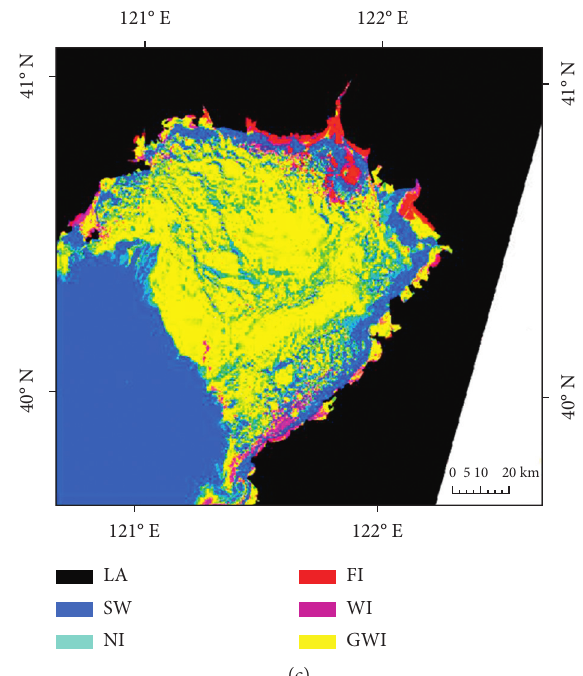
Figure 9: Comparison of sea ice classification results by different methods for the images acquired from 11 February 2019. (a) Classification result of maximum likelihood method; (b) classification result of support vector machine method; (c) classification result of our method.